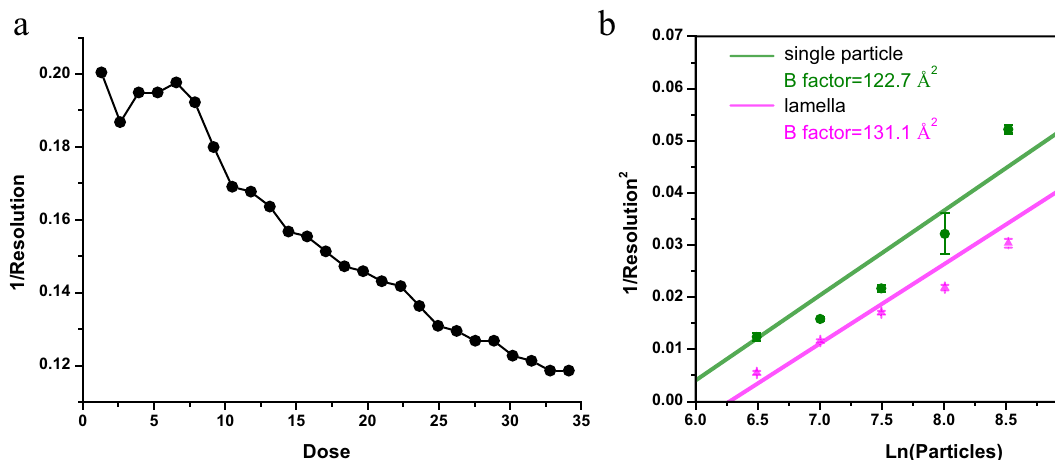
Fig. 5 | Frame motion analysis and B factor estimation on P. purpureum lamellae. a Inverse of resolution plot against dose. The fi rst eight electrons are reconstructed with the highest resolution. b B factor plots for reconstructions of